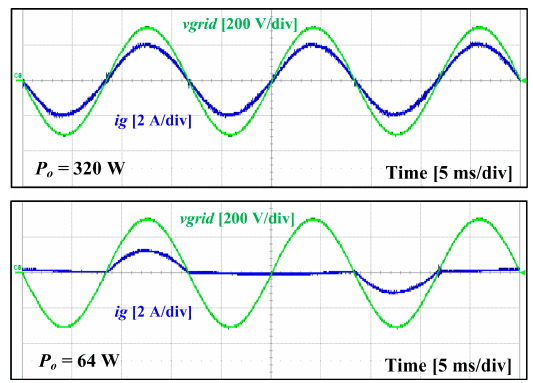
Figure 13. Grid voltage and current waveforms.